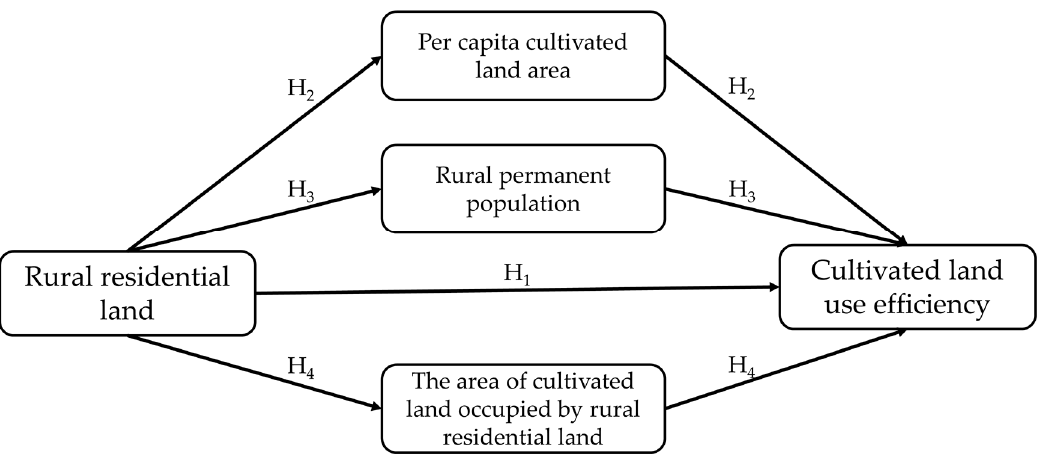
Figure 1. Theoretical framework.